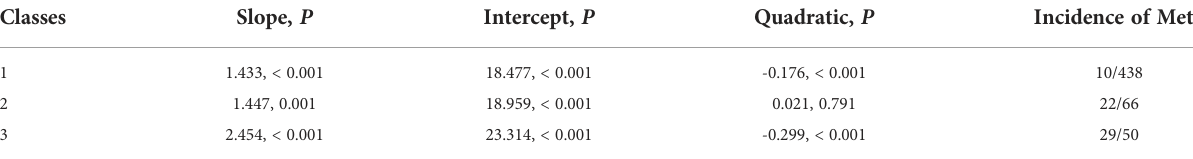
TABLE 2 Estimated mean of slope, intercept, and quadratic parameters for each class, and the incidence of MetS.